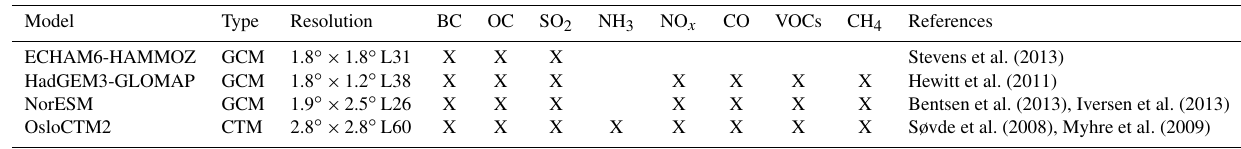
Table 1. General circulation models (GCMs) and chemical transport models (CTMs) used to calculate radiative forcing in this study. Reso- lution shows the horizontal resolution and the number of vertical layers. Radiative forcing has been calculated for emissions of these gases and particles by Bellouin et al. (2016).